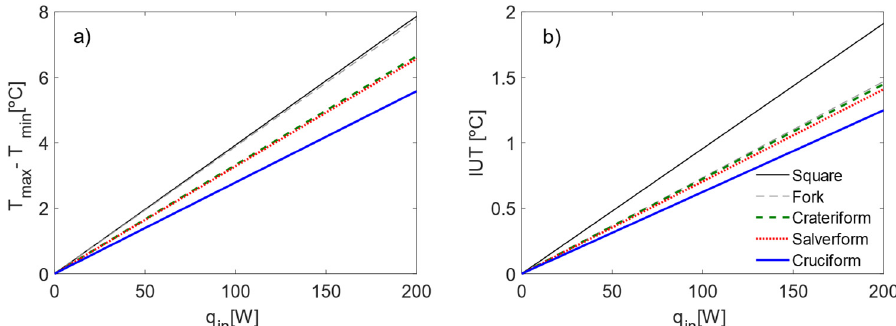
Figure 10. ( a ) Maximum variation in temperature and ( b ) Index of Uniform Temperature (IUT) for each configuration as a function of the thermal power input.